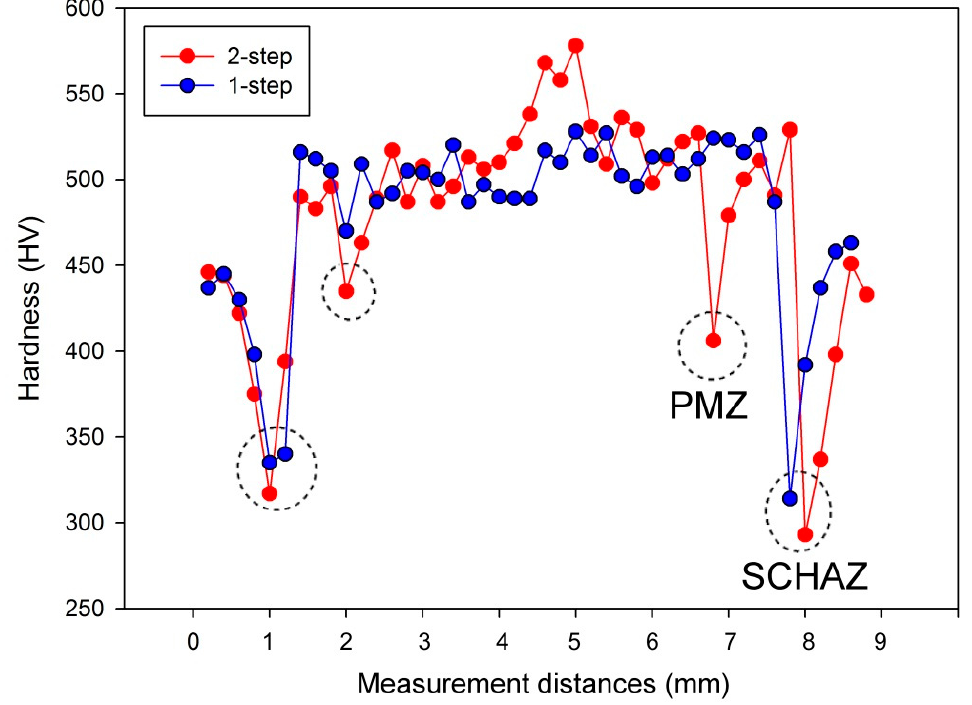
Figure 6. Hardness distribution of weldment at weld current of 6.0 kA in the one-step and the two-step RSW.